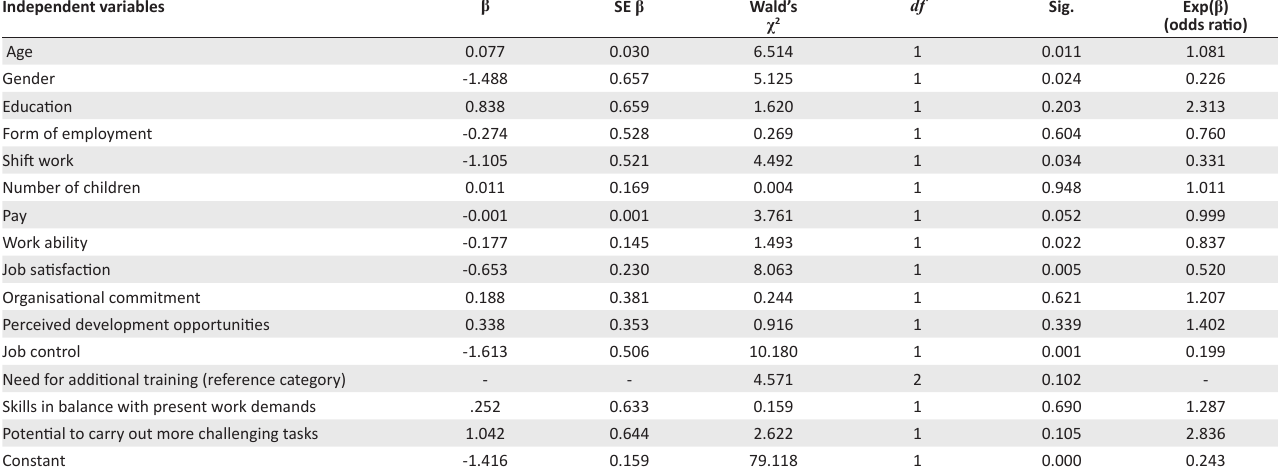
TABLE 5: Logistic regression analysis of the intention to retire